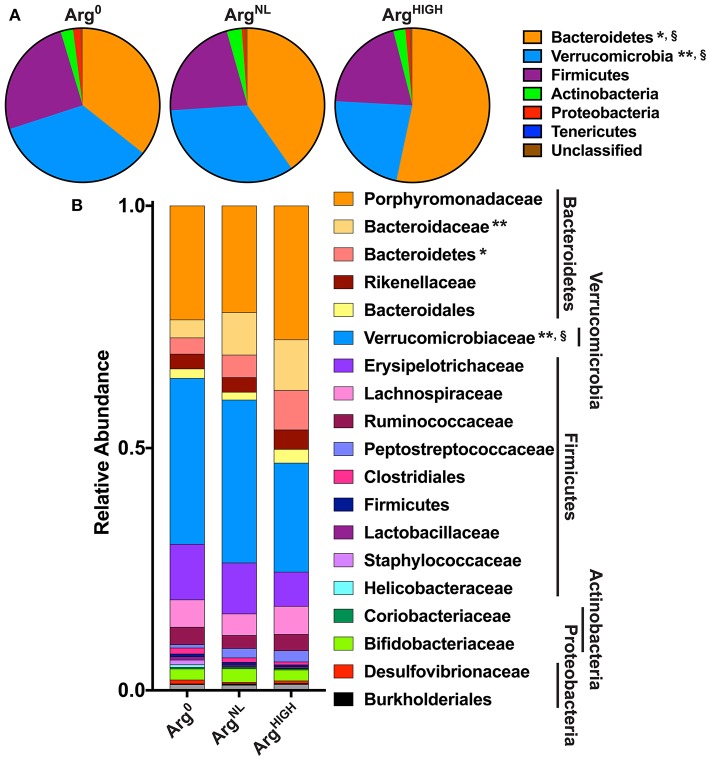
Analysis of the gut bacterial community composition. Variation in bacterial community composition at phylum (A) and family (B) levels is expressed as a percentage of the total community. *P < 0.05, **P < 0.01 denotes significant difference vs. Arg0 group; §P < 0.05, compared to the ArgNL group; statistics were performed using ANOVA with the Tukey test.